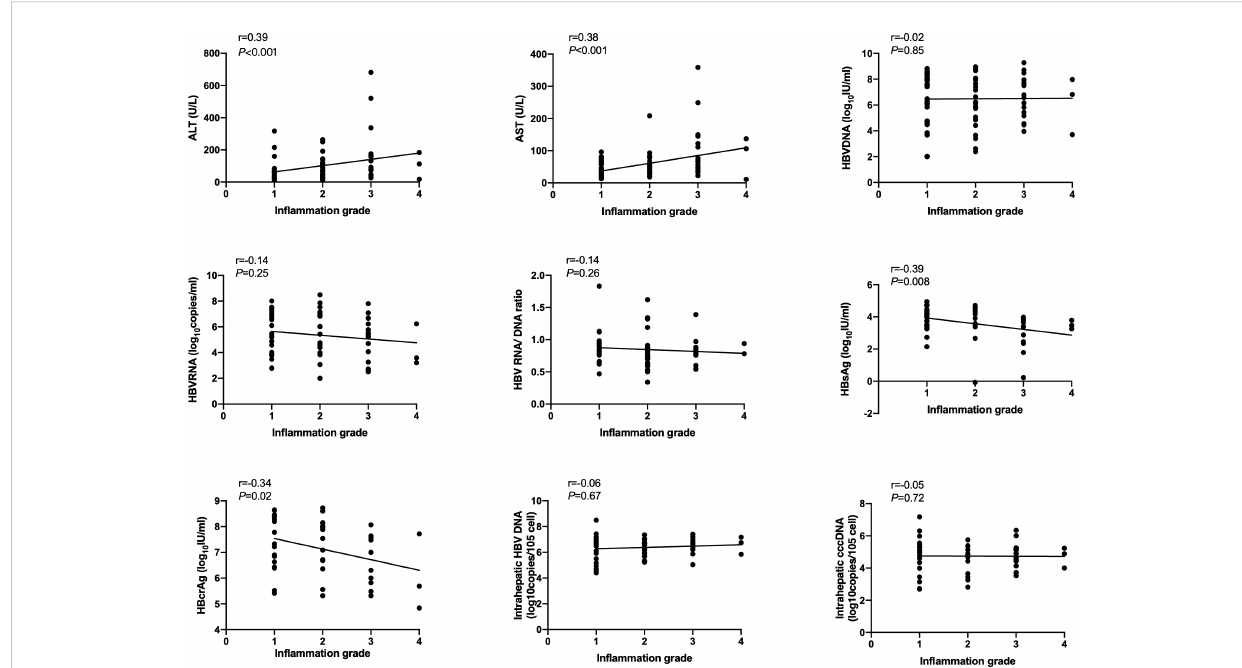
FIGURE 1 Correlation of HBV markers, ALT and AST with in fl ammation grade according to Scheuer scoring system in HBeAg-positive CHB patients at baseline. HBsAg, hepatitis B surface antigen; HBcrAg, hepatitis B core-related